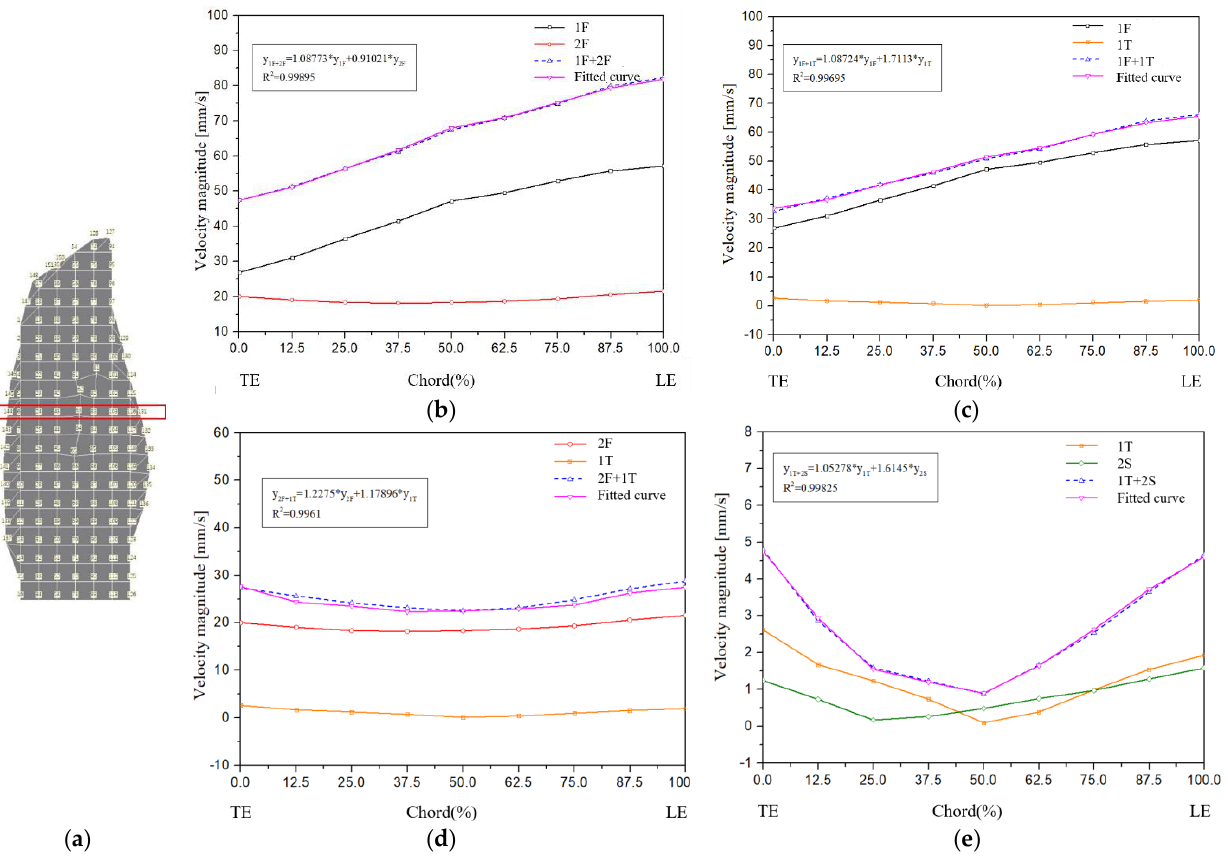
Figure 11. The response amplitude of different frequency superposition excitations with the same voltage: ( a ) Position of the measuring points; ( b ) 1F + 2F; ( c ) 1F + 1T; ( d ) 2F + 1T; ( e ) 1T + 2S.